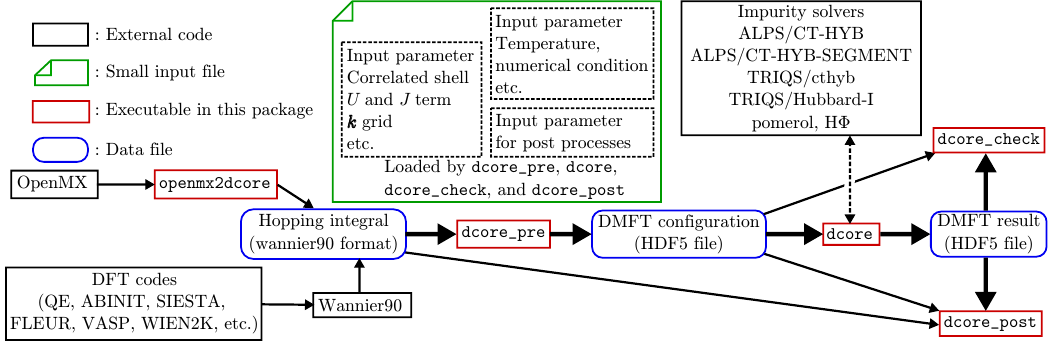
Figure 3: Structure of